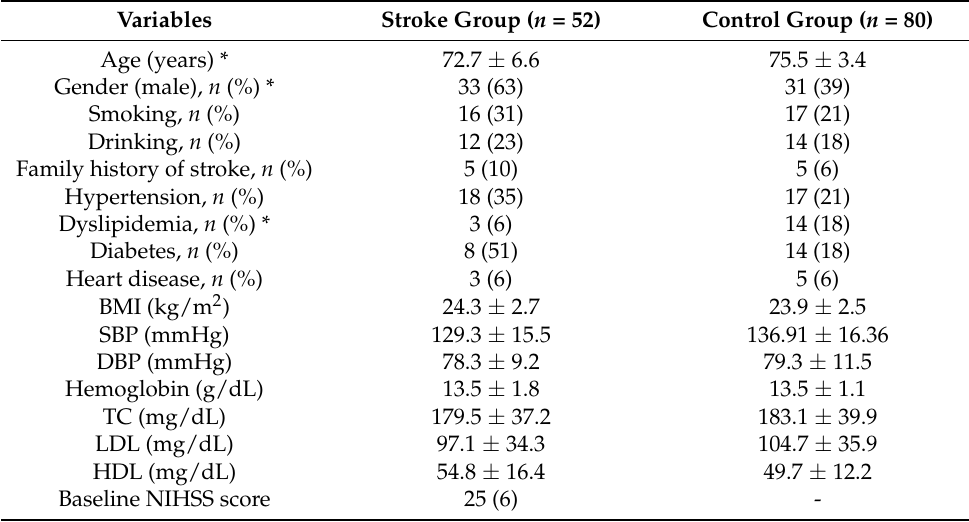
Table 1. Demographics and clinical data of the stroke and control